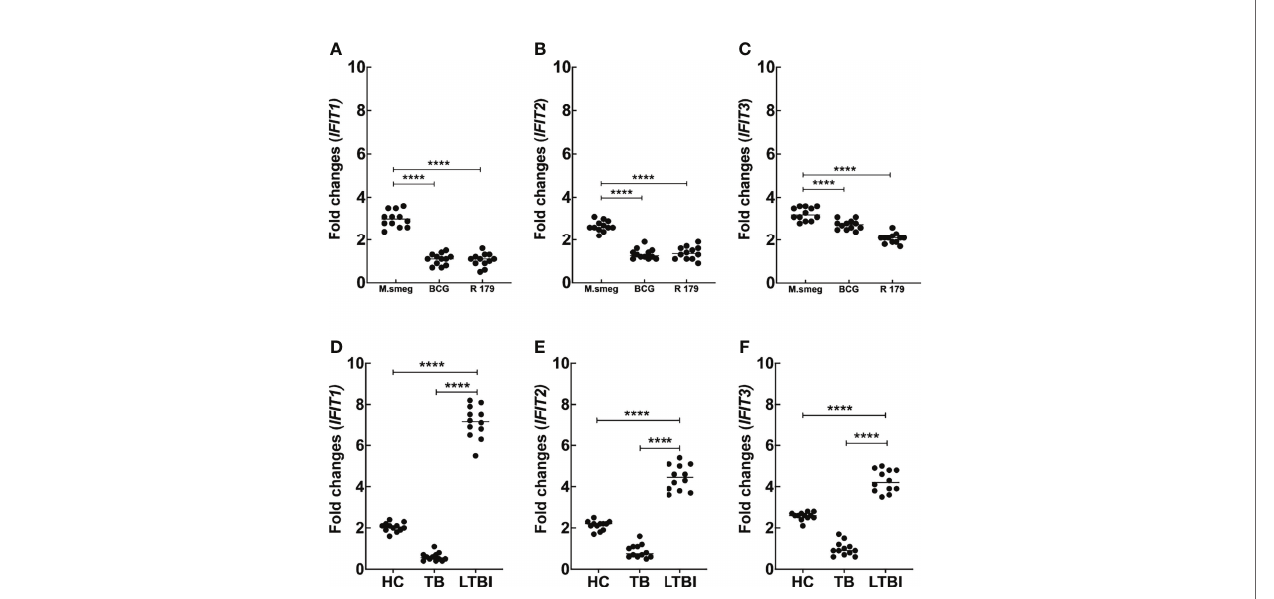
FIGURE 1 | Comparison of mRNA expression (fold changes) for in vitro protocol [ M. smegmatis, M. bovis BCG and M. tb R179] for (A) IFIT1 , (B) IFIT2 and (C) IFIT3. We also compared mRNA expression of IFIT1 , (D) , IFIT2 (E) and IFIT3 (F) in clinical cohort across HC, TB and LTBI group. We observed signi fi cantly higher expression of IFIT1, IFIT2 and IFIT3 in LTBI cases as compared to HC and TB. This indicates role of IFITs in mycobacterial containment in LTBI cases. For in vitro protocol, we also observed higher expression of IFITs in species with lower pathogenicity. BCG, Bacillus Calmette-Guerin; HC, healthy control; IFITs , interferon- induced protein with tetratricopeptides; LTBI, latent tuberculosis infection; TB, tuberculosis Supplementary Figures 7A – C depicts the mRNA fold changes of different genes (20 other genes) across the Clinical and in vitro protocols. ****p <